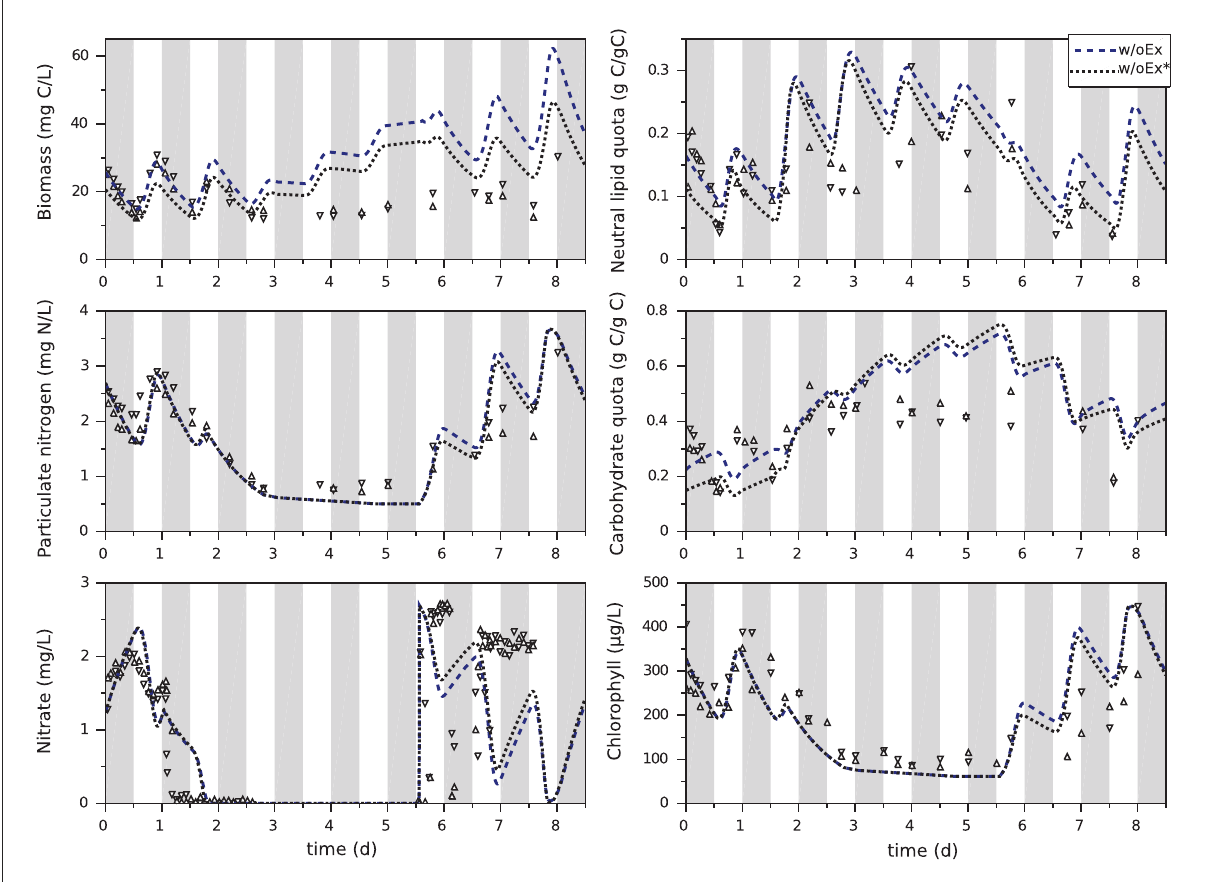
FIGURE2 Calibration of the original model with the first day (w/oEx) or the whole experiment (w/oEx*) of T. lutea culture under day/night cycles and nitrogen starvation. Experimental data taken from Lacour et al. (2012a) are represented by symbols. Gray bands represent night